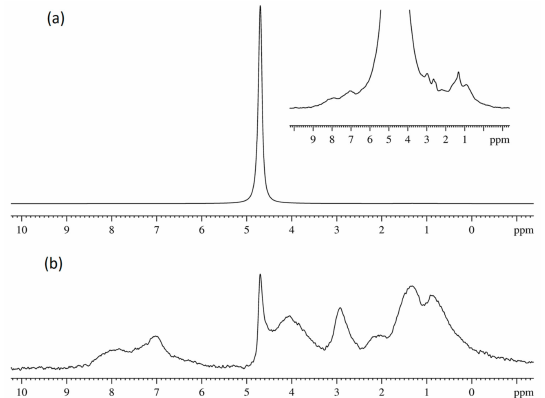
Figure 59. The RBCs suspension 1 H spectra with suppression of water signal—pulsed field gradient amplitude g = 0.375 T/m ( a ) and g = 10.5 T/m ( b ). 0–1.70 ppm: (CH2) n and CH3 groups of lipids; 6–9 ppm: protein component (protons of aromatic rings and NH and OH groups. Reprinted with permission from [171]. Copyright 2016 Springer Nature.